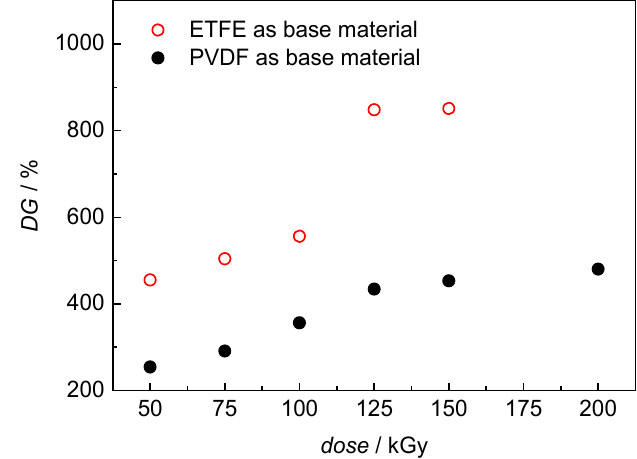
Figure 1. Variation of DG with pre-irradiation dose for graft copolymerizations on PVDF and ETFE with f AMPS = 0.5, V m = 0.2, reaction time 4 h at 80 °C.